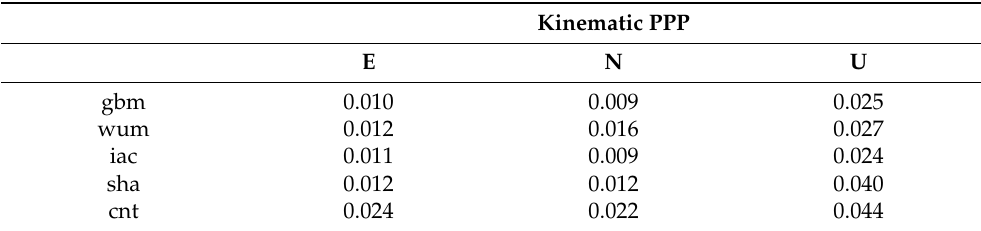
Table 9. The 25th percentile of the positioning accuracy (unit: m) in the ENU directions derived from BDS-3 kinematic PPP with five precise products.